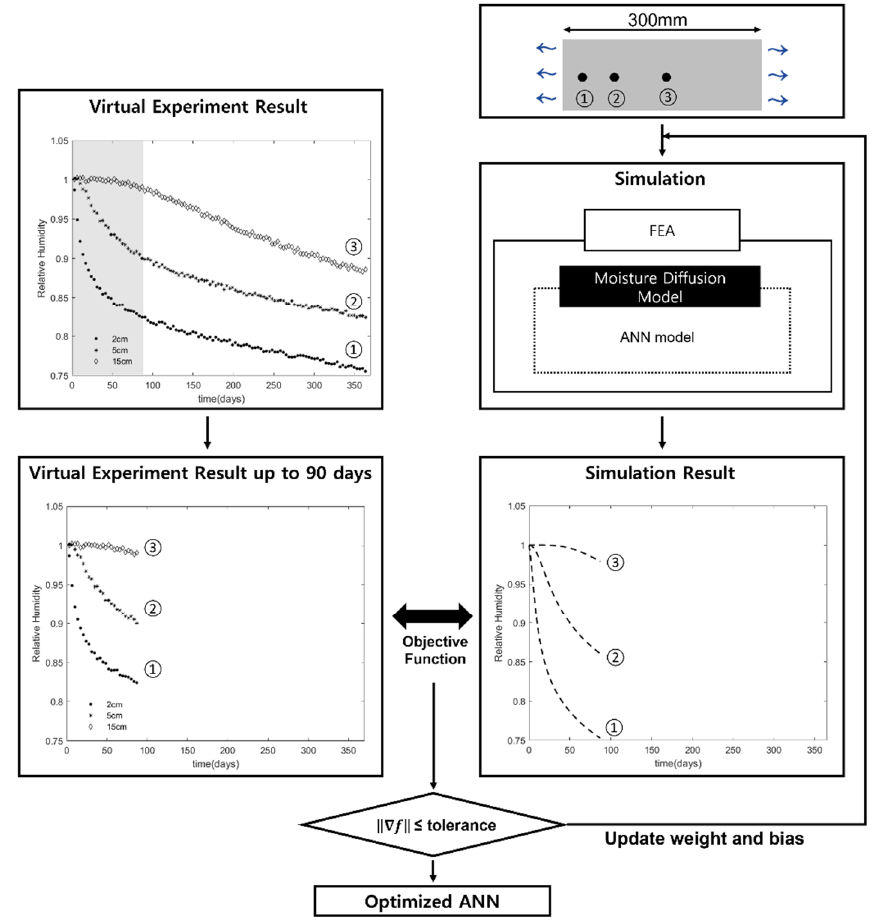
Figure 8. The schematic flow of inverse